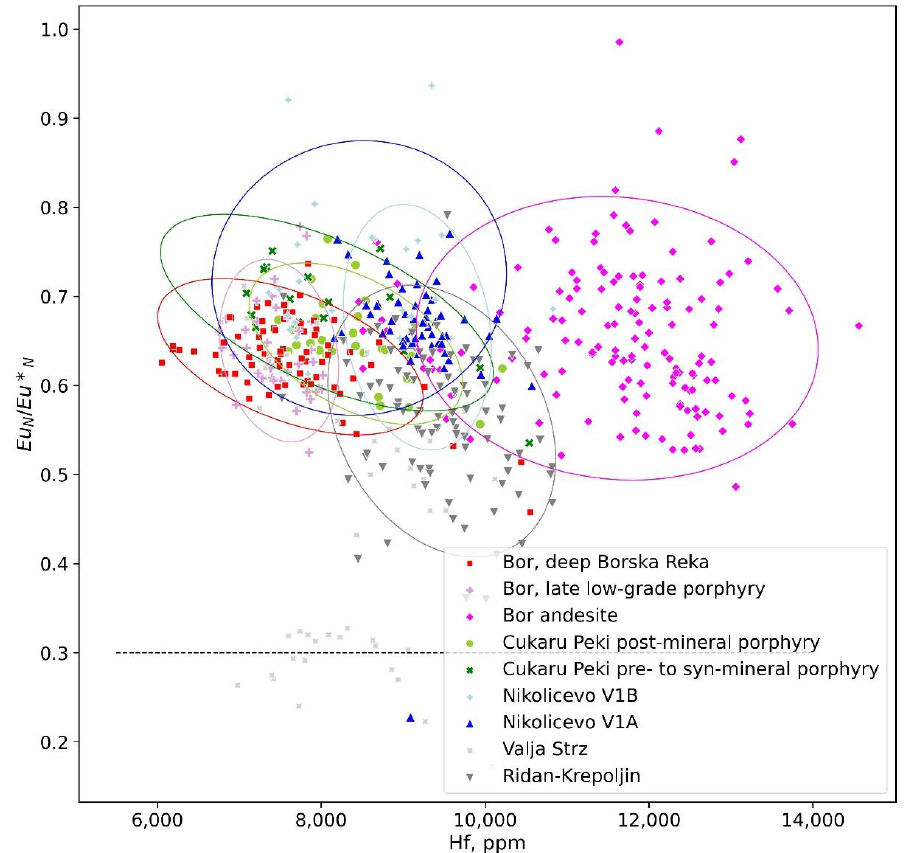
Figure 9. EuN/Eu*N vs. Hf of zircons; data and 95% confidence ellipses, showing very close resemblance between Bor deep Borska reka andesites and Cukaru Peki porphyries, as well as an overlap between Nikolicevo, Cukaru Peki and Bor porphyries, and potentially, a lower degree of fractionation for Bor andesites. Due to large scatter of Valja Strz samples, no confidence ellipses are plotted for this sample.